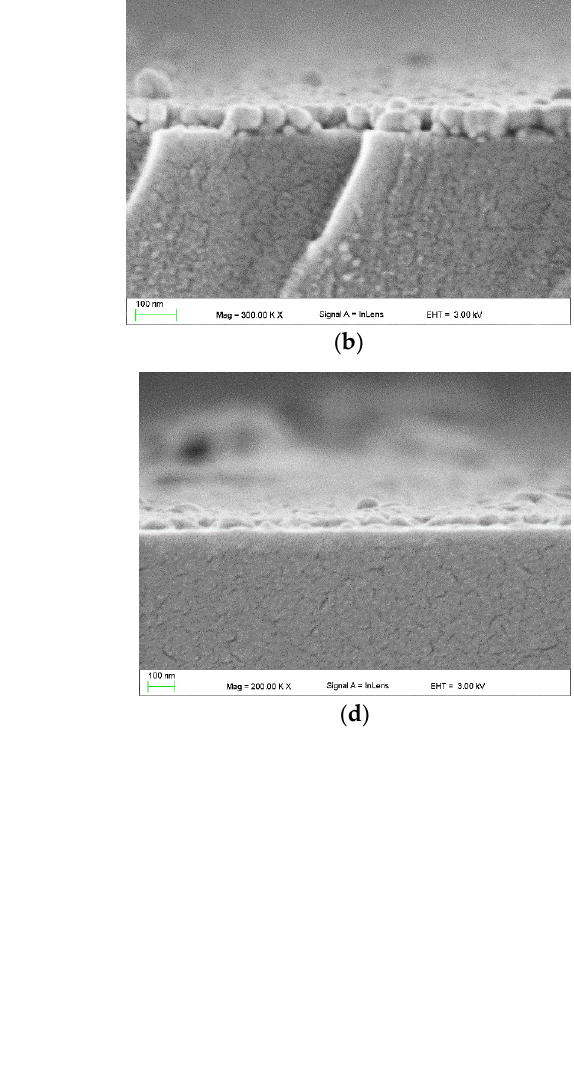
Figure 10. Cross ‐ section SEM images of the ZnO films, respectively: ZnO ‐ 2 ( a ), ZnO ‐ 14 ( b ), ZnO ‐ 30 ( c ), ZnO ‐ 41 ( d ), and ZnO ‐ 64 ( e ).